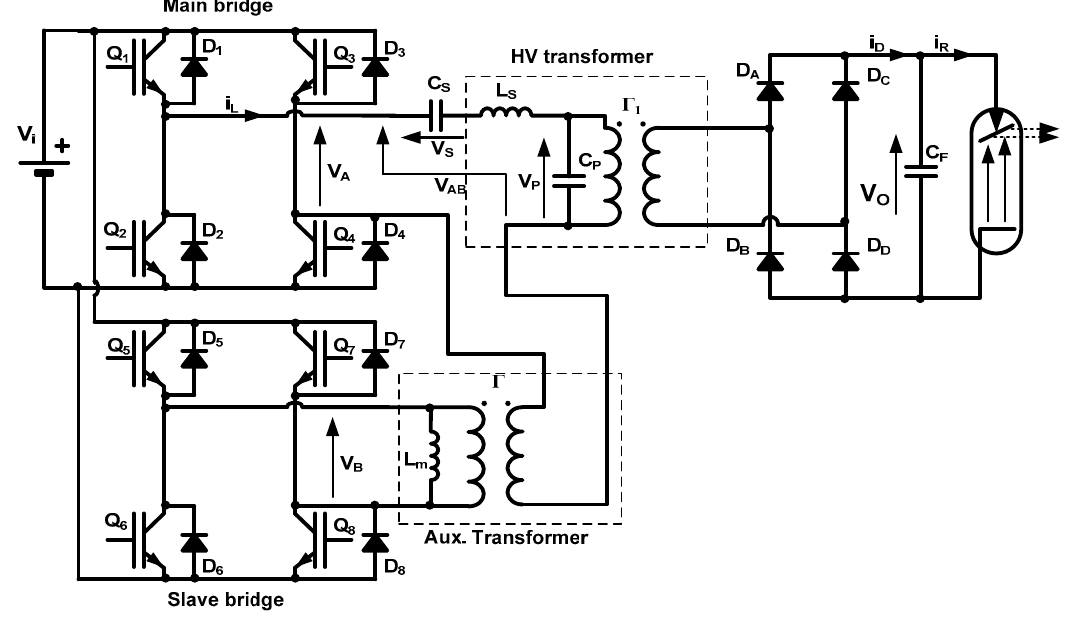
Figure 3. Multilevel topology proposed.